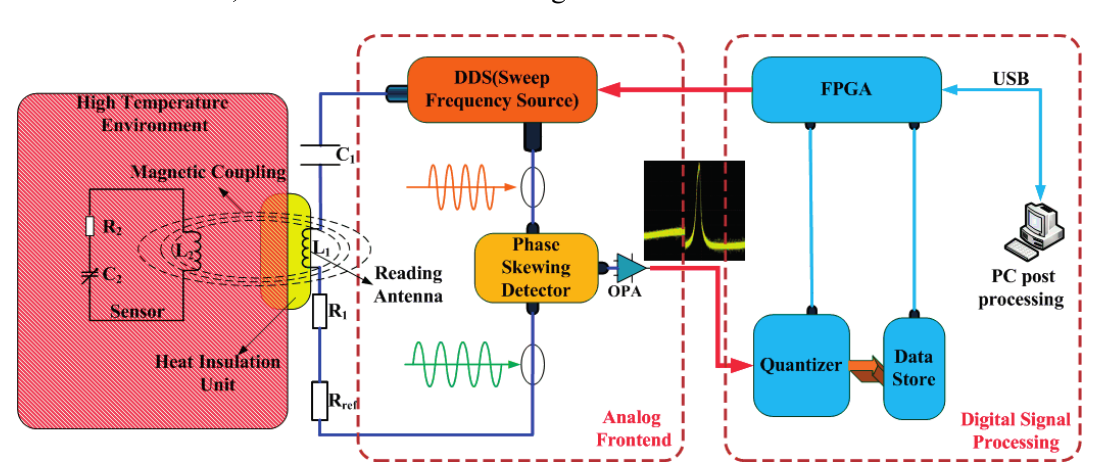
Figure 1. Block diagram of the wireless measurement